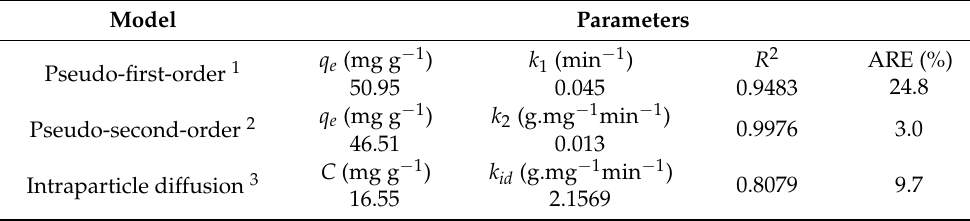
Figure 11. Adsorption kinetics for MB adsorption on biomass. Table 2. Kinetic values calculated for MB sorption onto